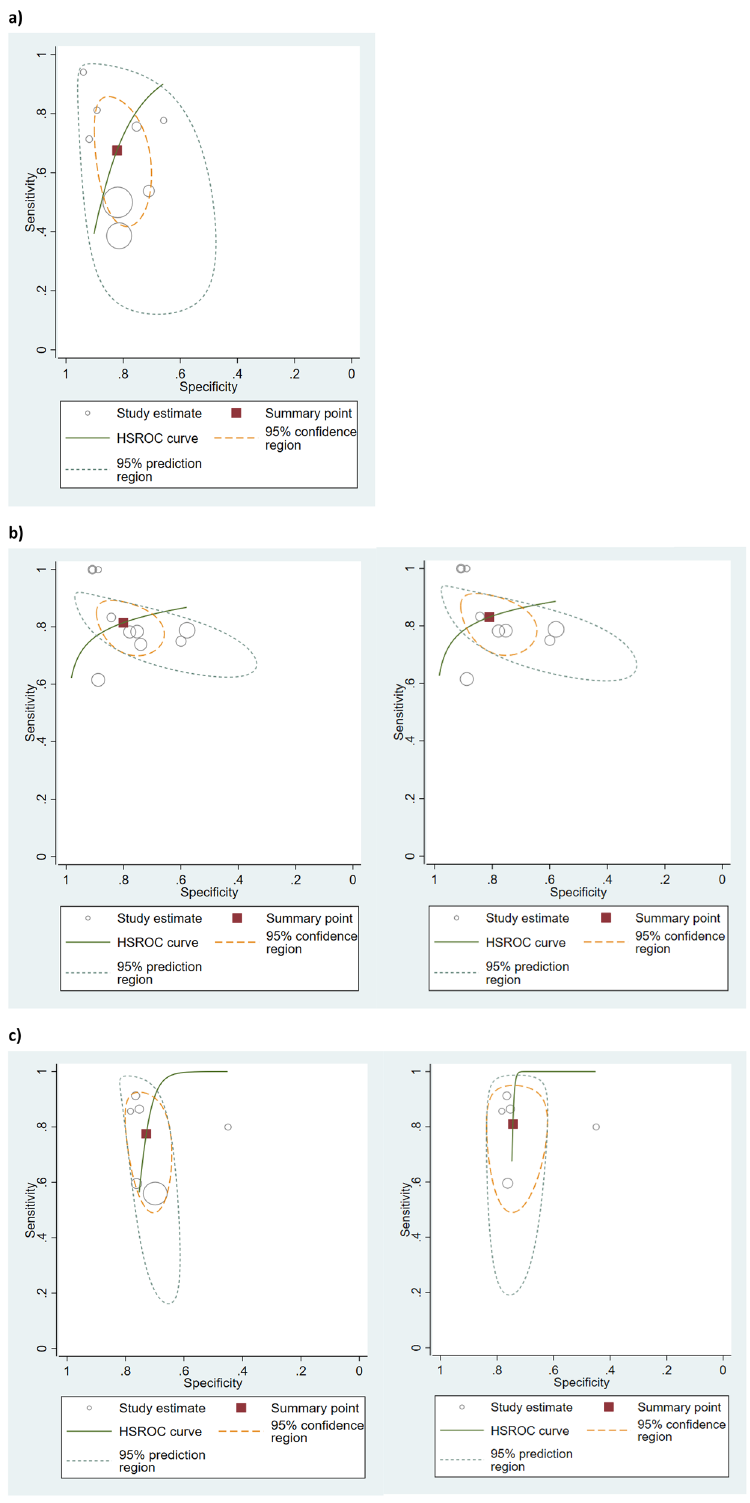
Figure 6. ( a ) hSROC of pNGAL taken at < 4 h post CPB, ( b ) hSROC of pNGAL taken at 4–8 h post CPB: left hSROC including all studies and right hSROC following removal of Haase, 2009 study due to possible incorrect subgrouping, ( c ) hSROC of pNGAL taken at 24 h post CPB: left hSROC including all studies and right hSROC following removal of Perry, 2010 study due to high risk of